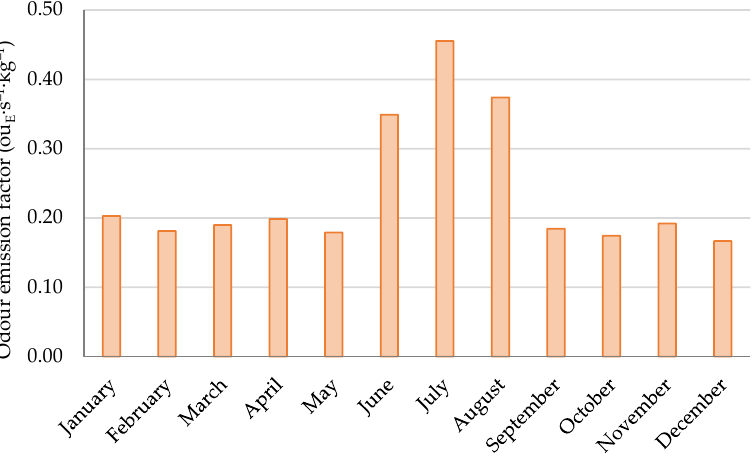
Figure 8. Odour emission factors for breeding hens for eggs.